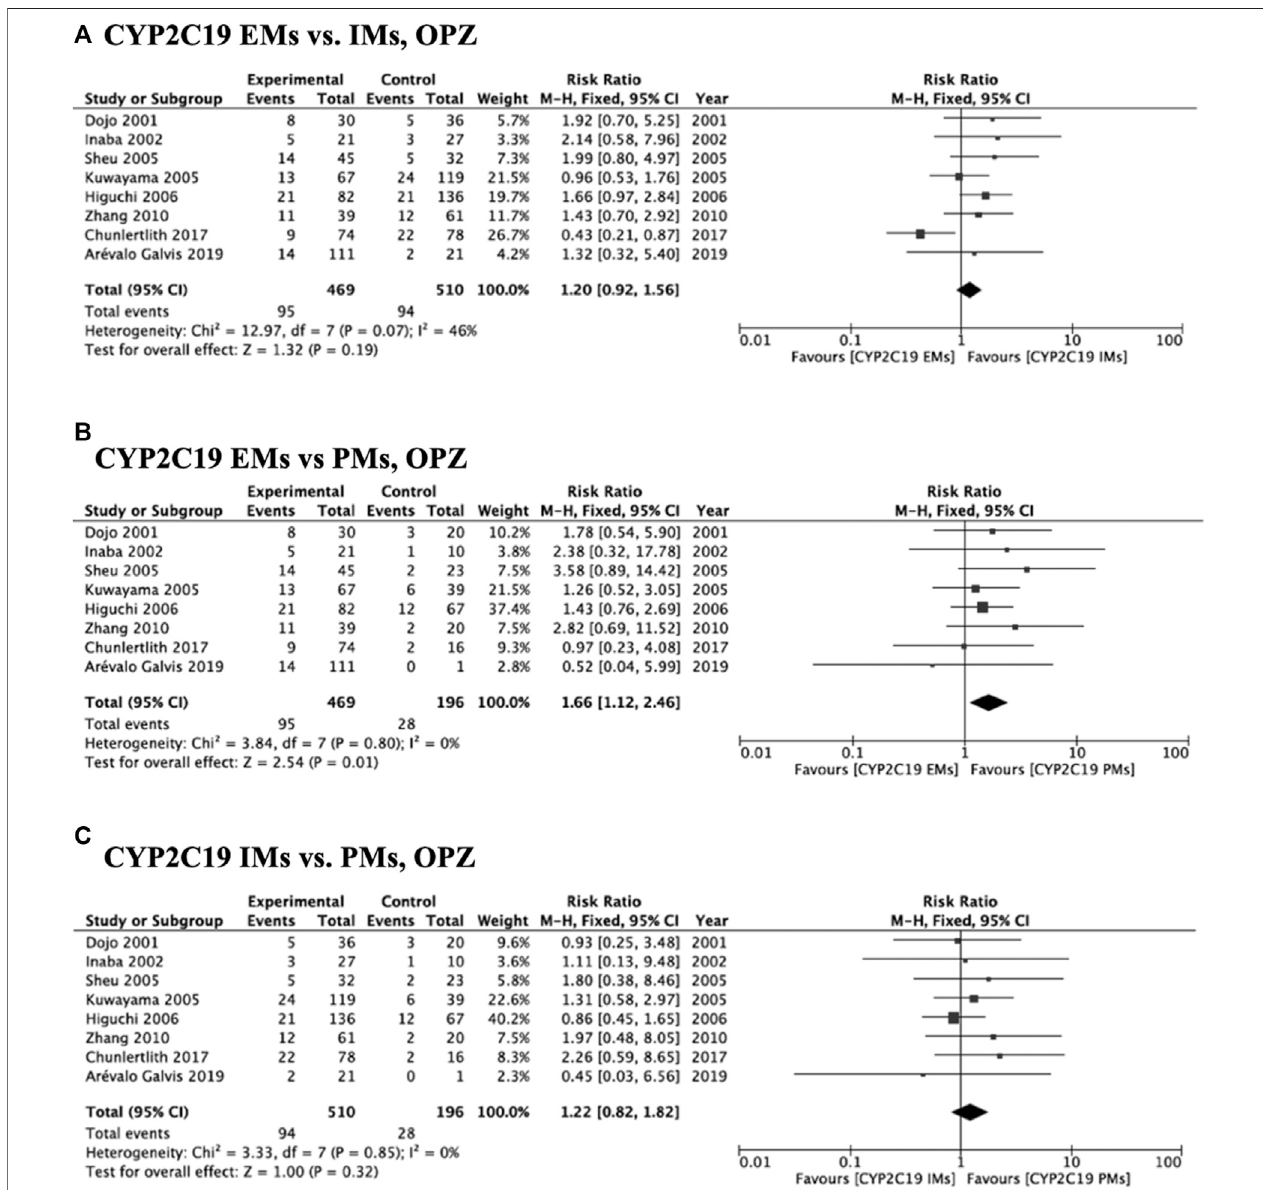
FIGURE 2 | Forest plots of H. pylori cure rates of OPZ-amoxicillin-clarithromycin regimen among different CYP2C19 genotypes in the fi xed-effects model. (A) CYP2C19 EMs vs IMs, (B) EMs vs PMs and (C) IMs and PMs.; Abbreviations: CI, con fi dence interval; EM, extensive metabolizer of CYP2C19; IM, intermediate metabolizer of CYP2C19; OPZ, omeprazole; PPI, proton pump inhibitor; PM, poor metabolizer of CYP2C19; PPI, proton pump inhibitor.